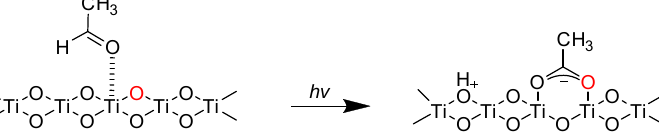
Figure 11. Proposed reaction mechanism of the acetaldehyde reaction with bridging-oxygen atoms to form acetate, in the absence of O 2 .